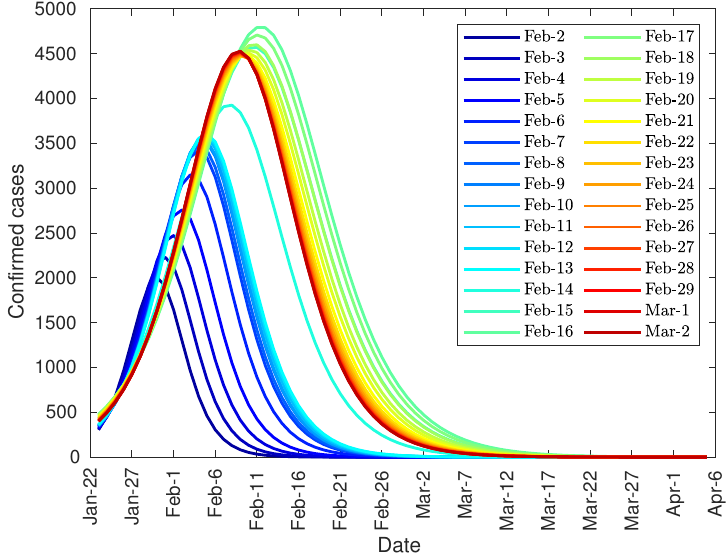
Figure 4. Evolution of the peak of diagnosed COVID-19 patients in China.